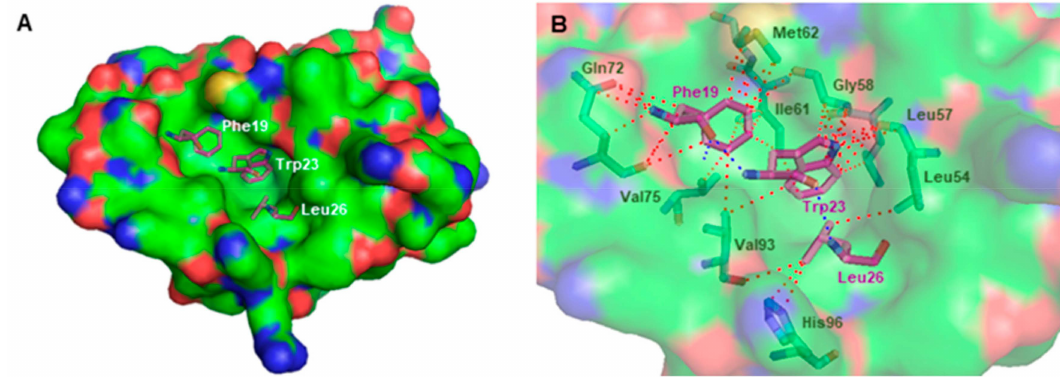
Figure 5. ( A ) Crystallographic p53 (for simplification, only Phe19, Trp23, and Leu26 residues are represented as purple sticks) bound to the three pockets of MDM2 (solid surface). ( B ) Binding mode of crystallographic p53 (for simplification, only residues Phe19, Trp23, and Leu26, are represented as purple sticks) in the hydrophobic cleft of MDM2 (transparent surface); MDM2 amino acid residues involved in interactions with p53 are represented as green sticks. Structural data were obtained from the X-ray crystal structure of MDM2-p53 complex (Protein Data Bank (PDB) id 1YCR). MDM2 is represented as surface, where carbon, oxygen, nitrogen, and sulfur are represented in green, red, blue, and yellow, respectively. Hydrogen-bonding interactions are depicted with a dashed blue line. Other types of interactions are represented as a dashed red